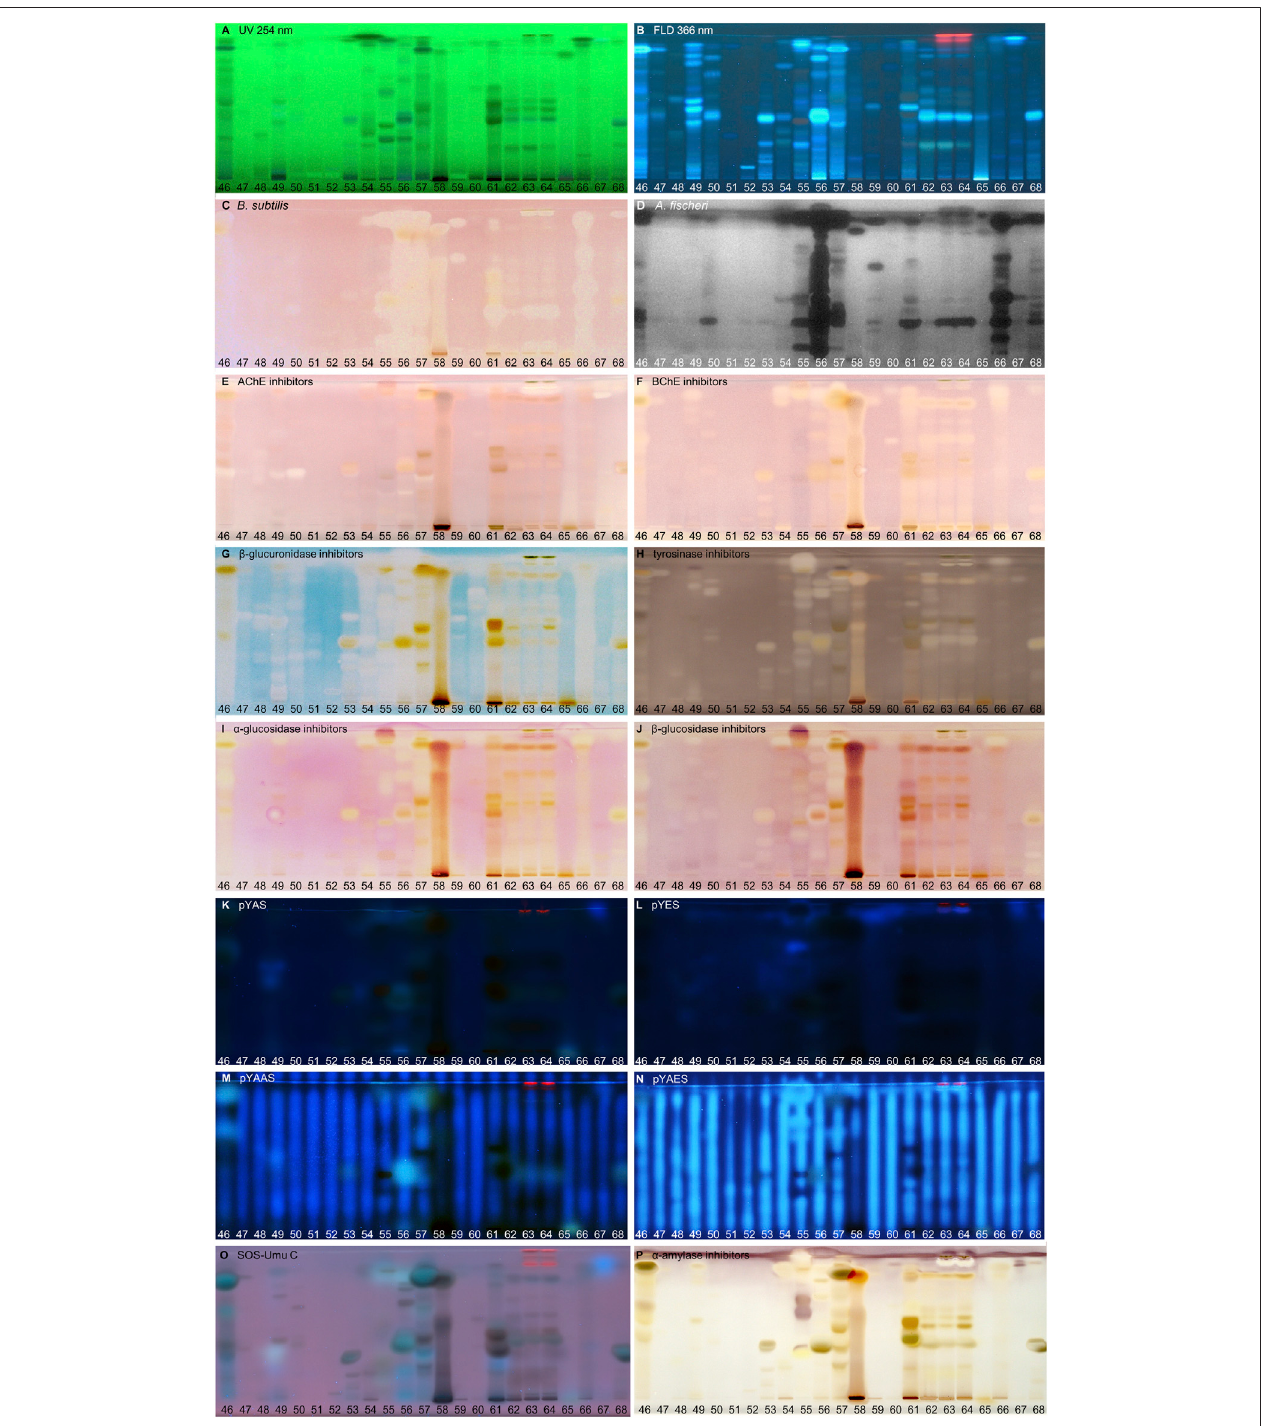
FIGURE 4 | NP-HPTLC − UV/Vis/FLD − EDA pro fi les of the plant extracts no. 46 – 68. Separation of the applied botanicals (4 µL/band, assignments in Table 1 ; solventblankBforcomparison)onHPTLCplatesilicagel60F 254 MS-gradewithethylacetate — toluene — formicacid — water(16:4:3:2, V/V/V/V )upto70 mm,detected atUV254 nm (A) ,FLD366 nm (B,K – O) ,andwhitelightillumination (C,E – J,P) afterthe B.subtilis bioassay (C) , A. fi scheri bioassaywithbioluminescencedepictedasa greyscaleimage, (D) andAChE (E) ,BChE (F) , β -glucuronidase (G) ,tyrosinase (H) , α -glucosidase (I) , β -glucosidase (J) ,and α -amylase (P) inhibitionassays,aswell as pYAS (K) , pYES (L) , pYAAS (M) , pYAES (N) , SOS-Umu-C (O) bioassays.